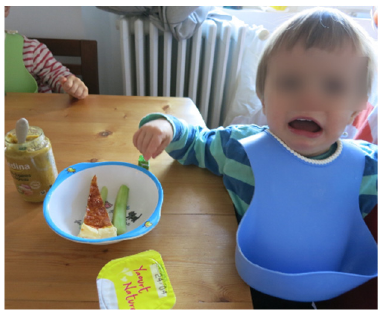
Picture 6: Arnaud, 18 months: Dinner “failure”, after failed attempt of a jar, proposal quiche/cucumber like the rest of the family, but without success. Did not eat anything, bottle offered and ok.